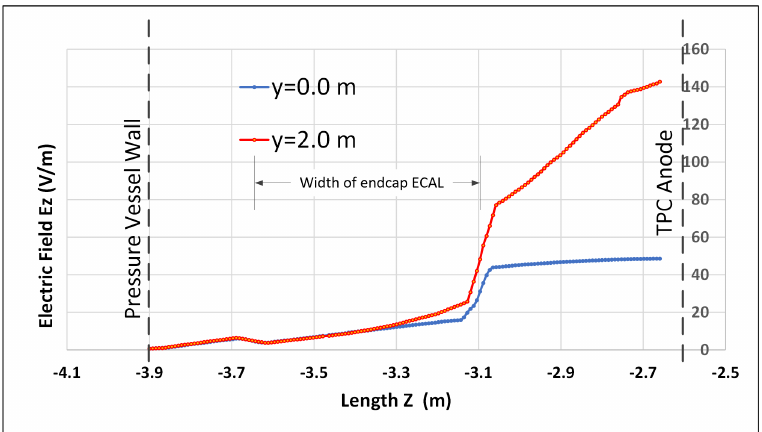
Figure 9. Blue: Electric field, E z , outside the TPC on the central axis of the pressure vessel. Red: Same plot except displaced from the central axis by y = 2